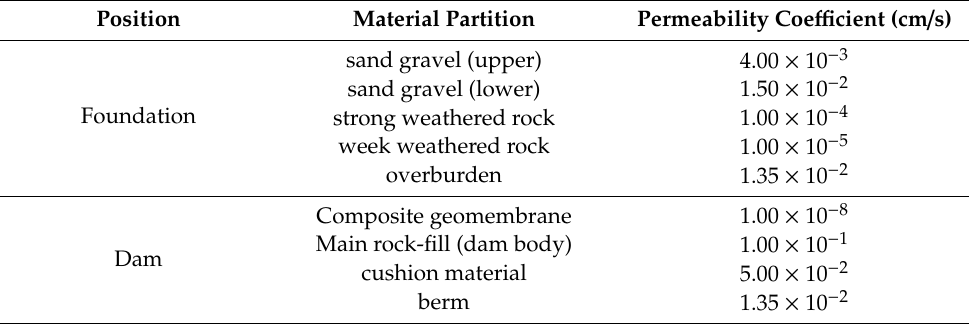
Table 1. Permeability coe ffi cients of the materials in each area.